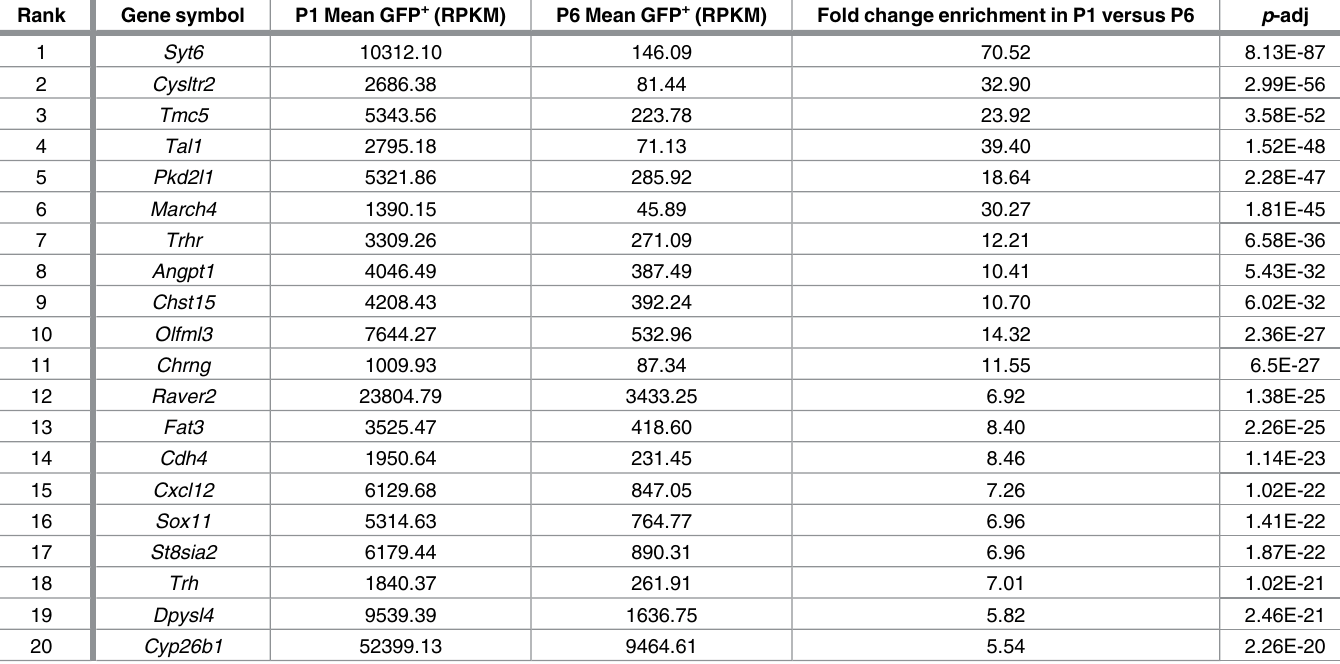
List of the 20 genes showing the greatest fold-change enrichment in P1 Lfng-GFP + cells compared P6 Lfng-GFP + cells. Ranking is based on the p value. The mean expression level (RPKM) is shown, together with the fold change of enrichment in P1 versus P6 cells. p- adj = adjusted p -value for the difference between P1 and P6